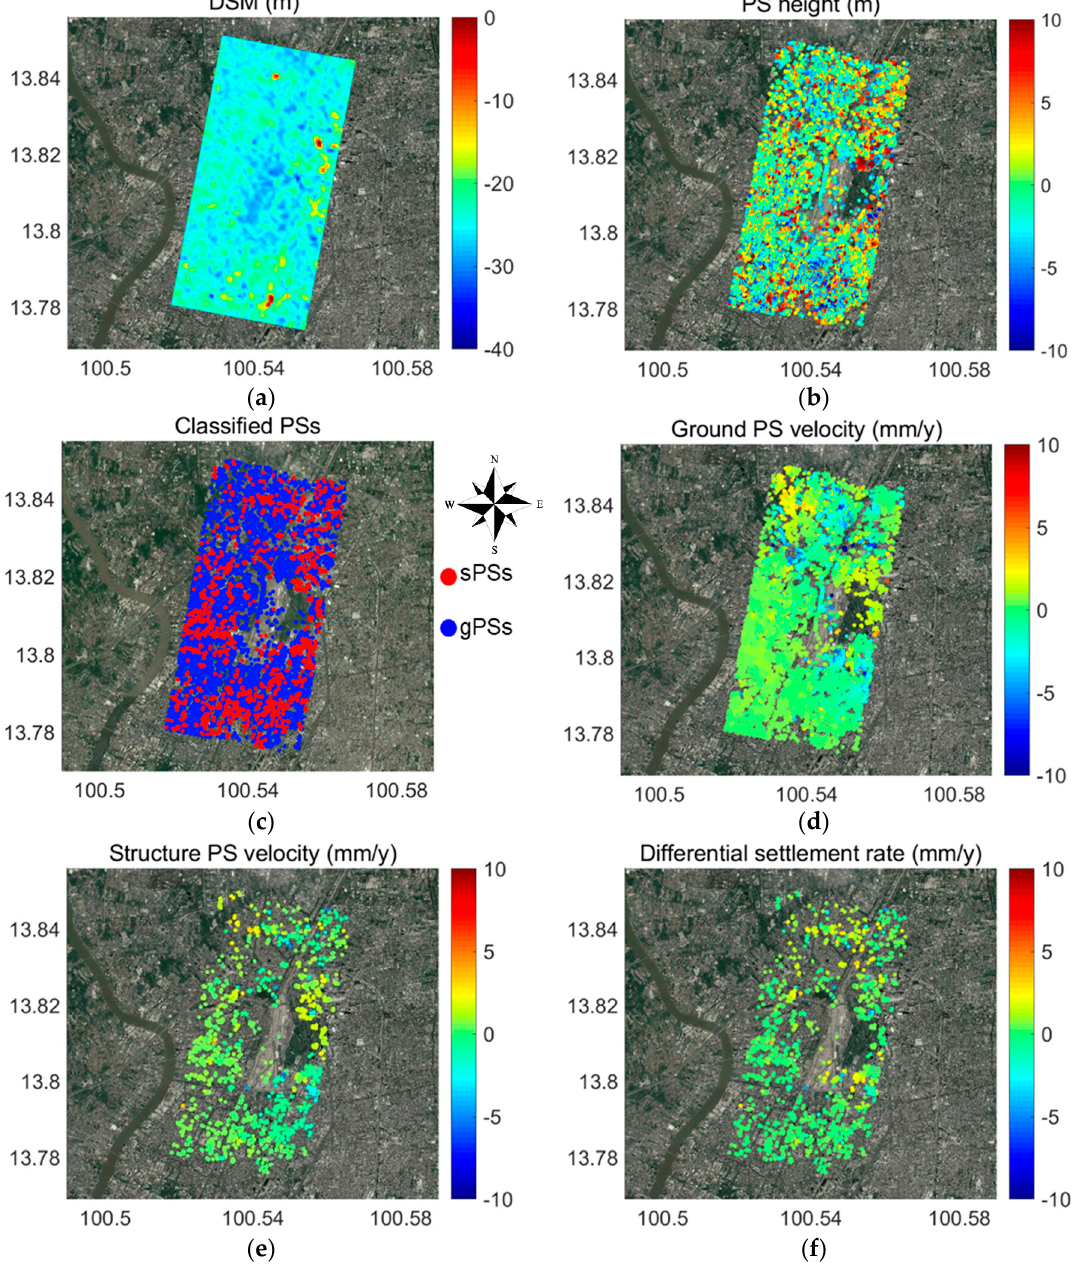
Figure 4. Enlarged maps for Area B. ( a ) DSM; ( b ) PS height; ( c ) classified PSs; ( d ) gPS velocity; ( e ) sPS velocity; and ( f ) DS rate. In ( c ), red and blue points denote sPSs and gPSs, respectively. The background images used in the panels were provided by Google [30] and Copernicus.